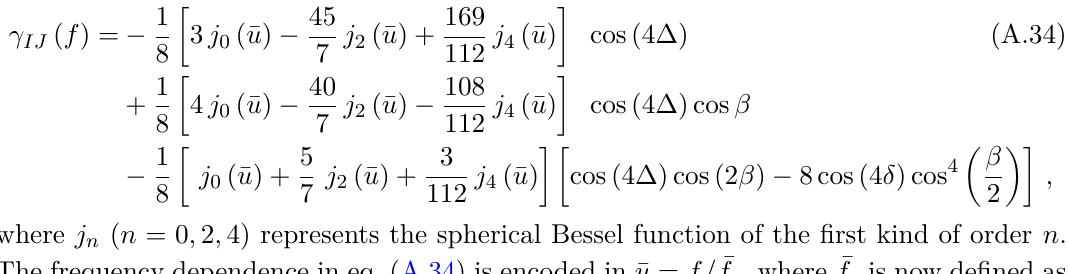
[see eq. (A.15)] [197, 198], IJ